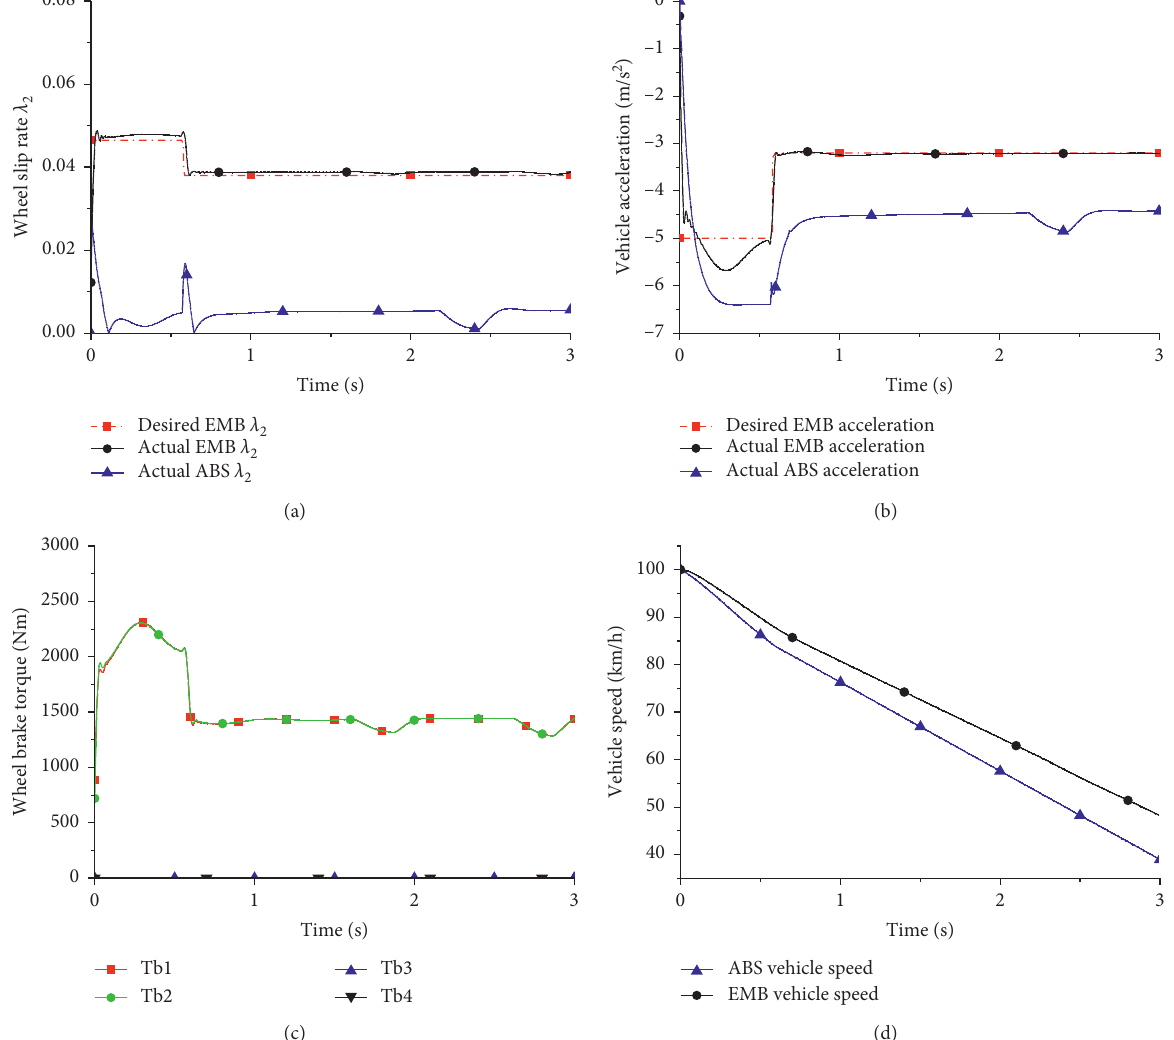
Figure 10: Medium comfort brake, switch dry asphalt pavement to wet asphalt pavement. (a) Wheel slip rate. (b) Vehicle acceleration. (c) Wheel brake torque. (d) Vehicle speed.